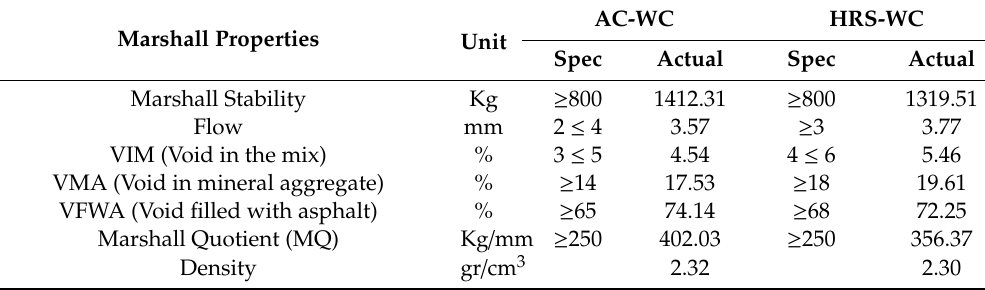
Table 5. Dynamic modulus of AC-WC and HRS-WC mixtures at different temperature and frequency.